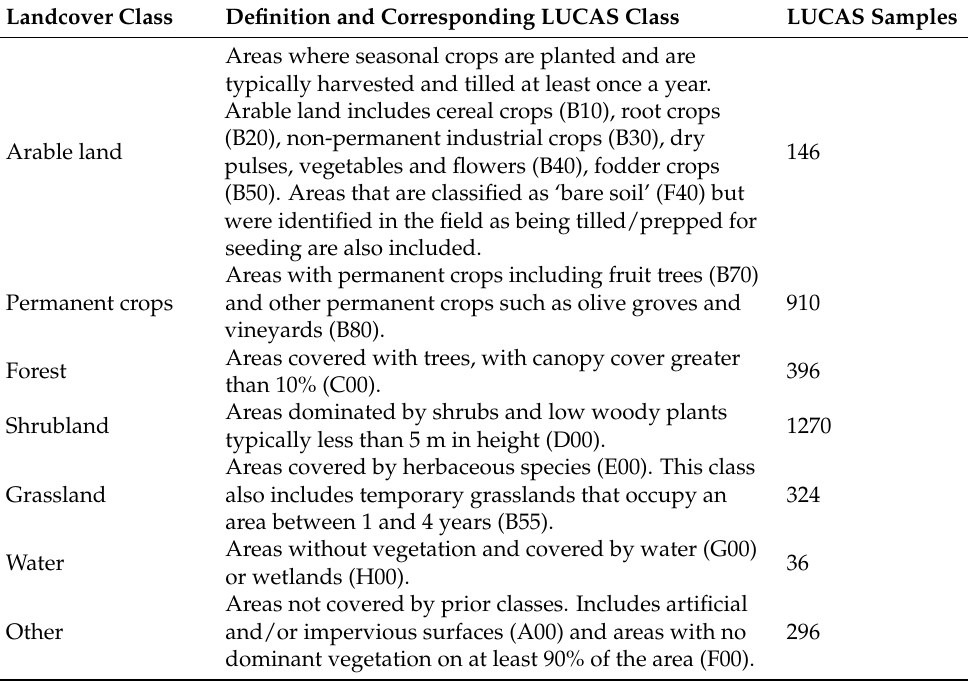
Table 1. Landcover class definitions with corresponding LUCAS classes and number of LUCAS samples used after